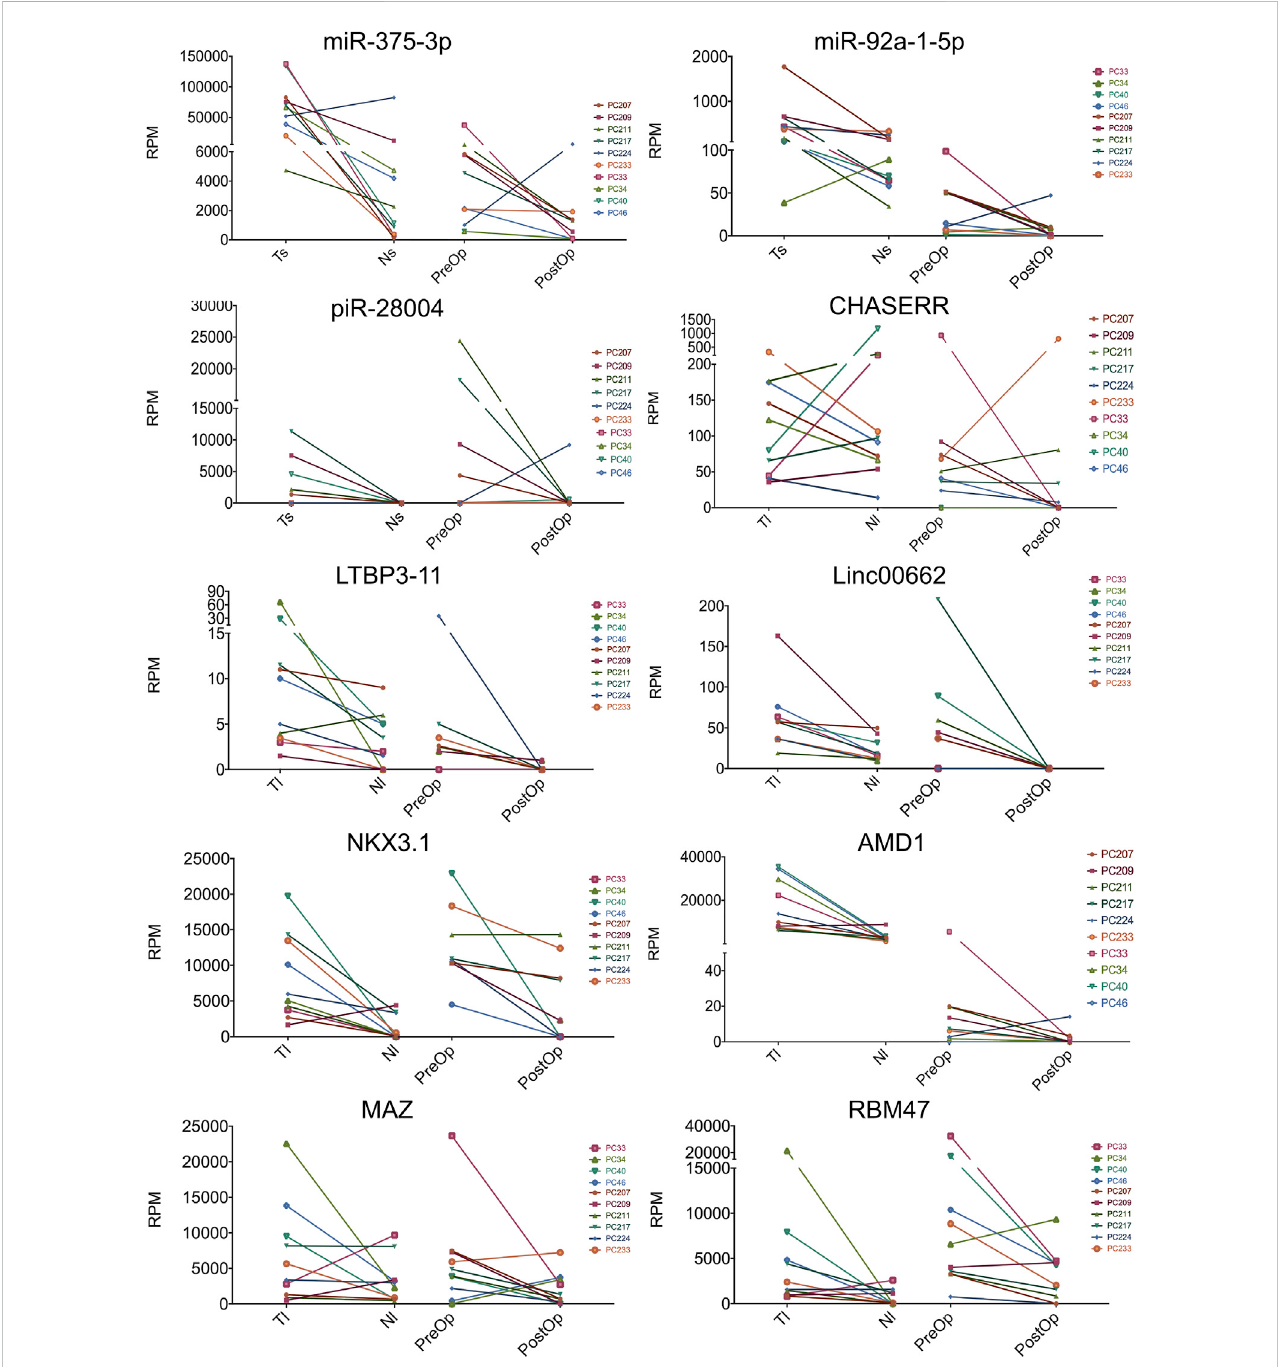
FIGURE 5 Selected biomarker candidates. The paired dot plots show the normalized read counts (reads per million mapped reads, RPM) for selected RNA biomarkers in tumor and normal prostate tissue small RNA libraries (TS and NS, respectively) or full transcriptome libraries (TL and NL), and pre-operation and post-operation urinary EVs. Log2 fold changes and multiple testing adjusted p values are shown in Supplementary Table